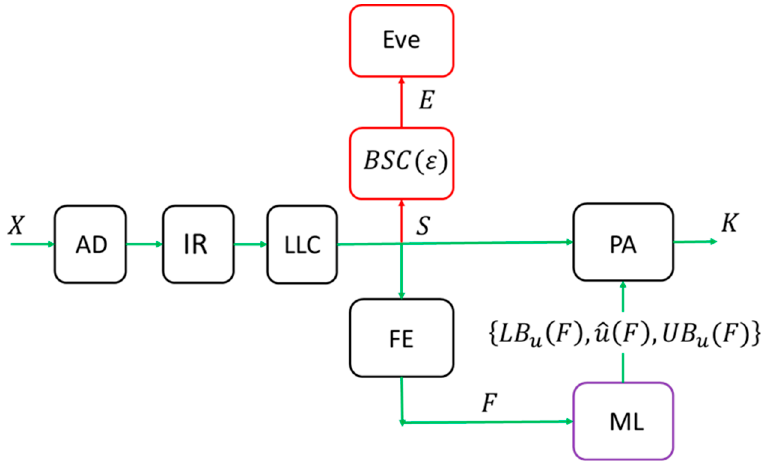
Figure 3. The basic architecture of the proposed system.